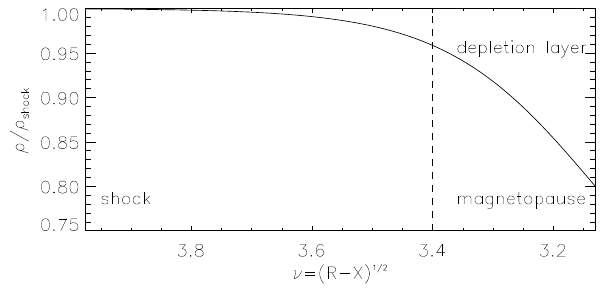
Fig. 2. Density profile in the magnetosheath exhibiting a depletion layer close to the magnetopause (with a 20% decrease). The coordinate system is the one used in the KF magnetic field model ( R bs = 12.8 R E and R mp = 9.8 R E are used).